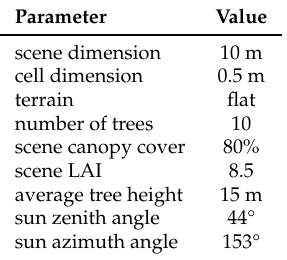
Table 2. Basic DART scene